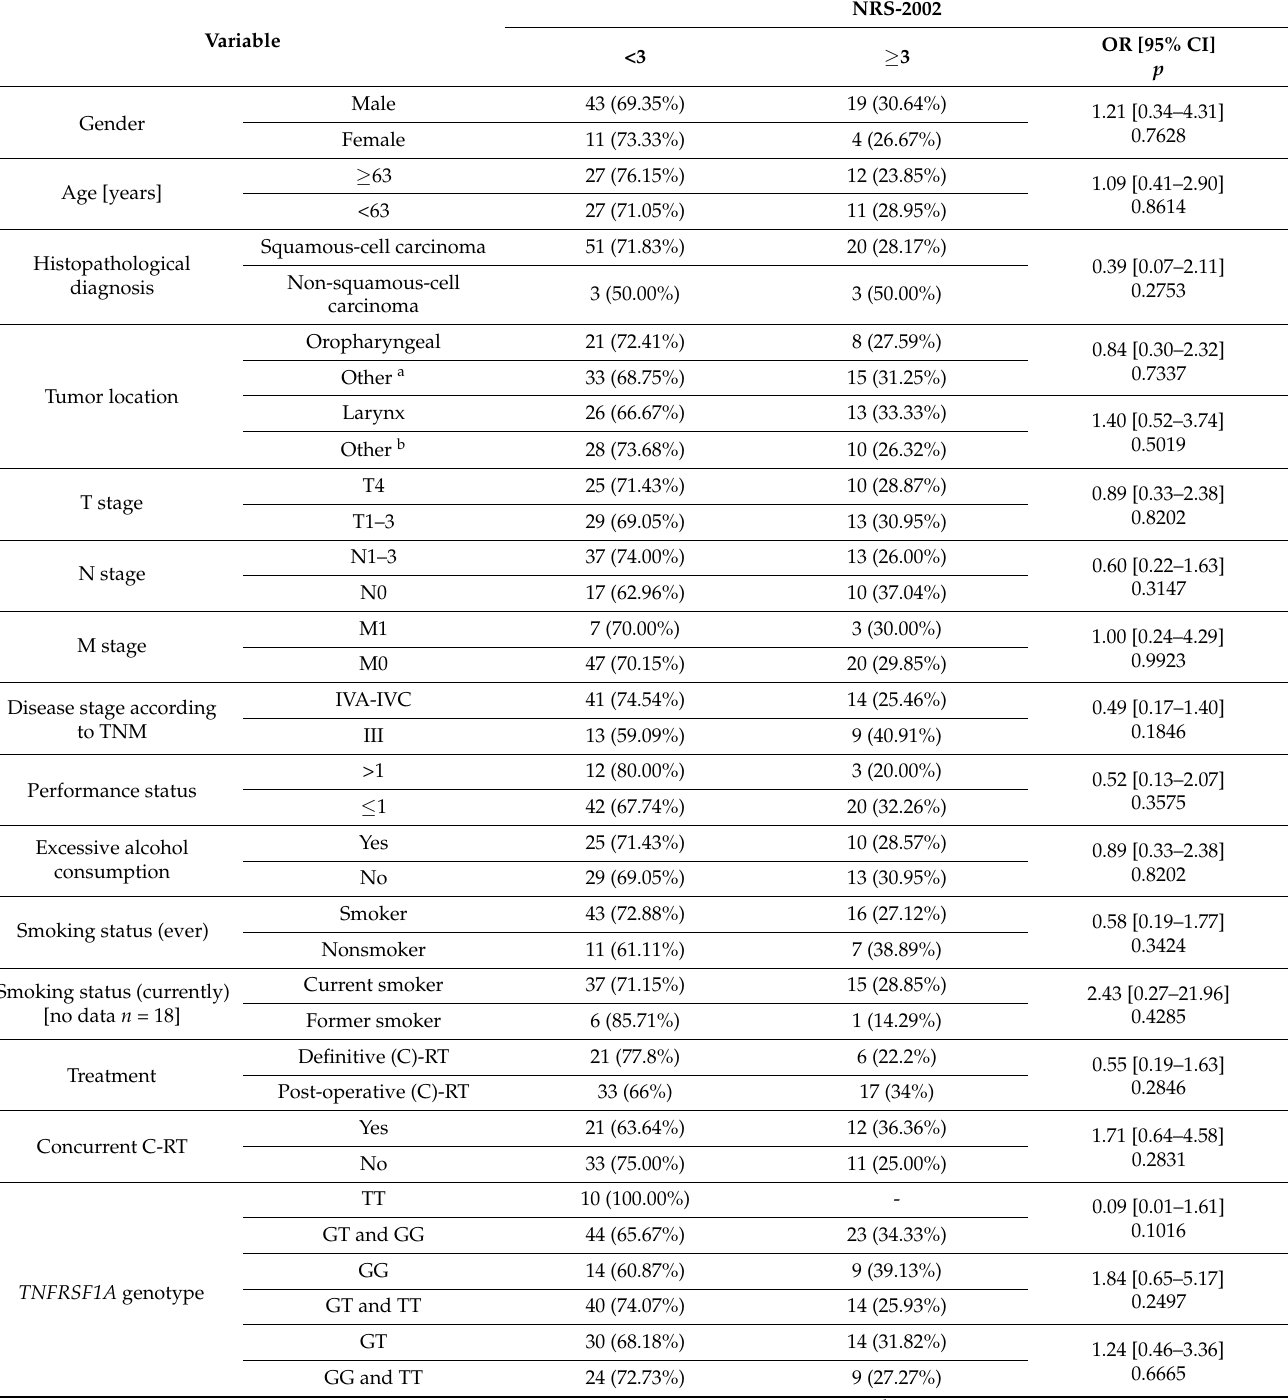
Table 3. The influence of the demographic, clinical, and genetic variables on the nutritional risk according to